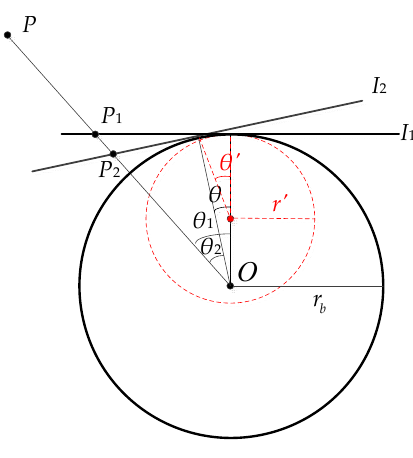
Figure 5. Camera rotation model.